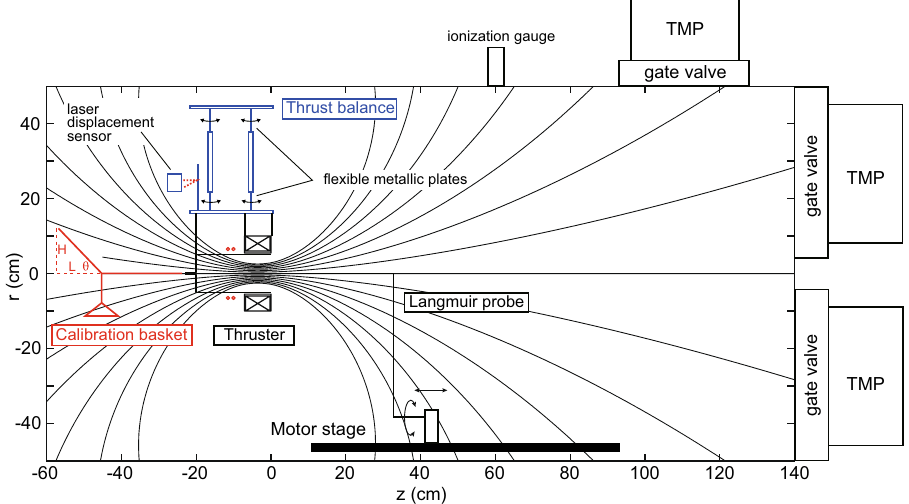
Figure 9. Schematic diagram of the experimental setup including the vacuum chamber, the thrust balance, the thruster, and the Langmuir